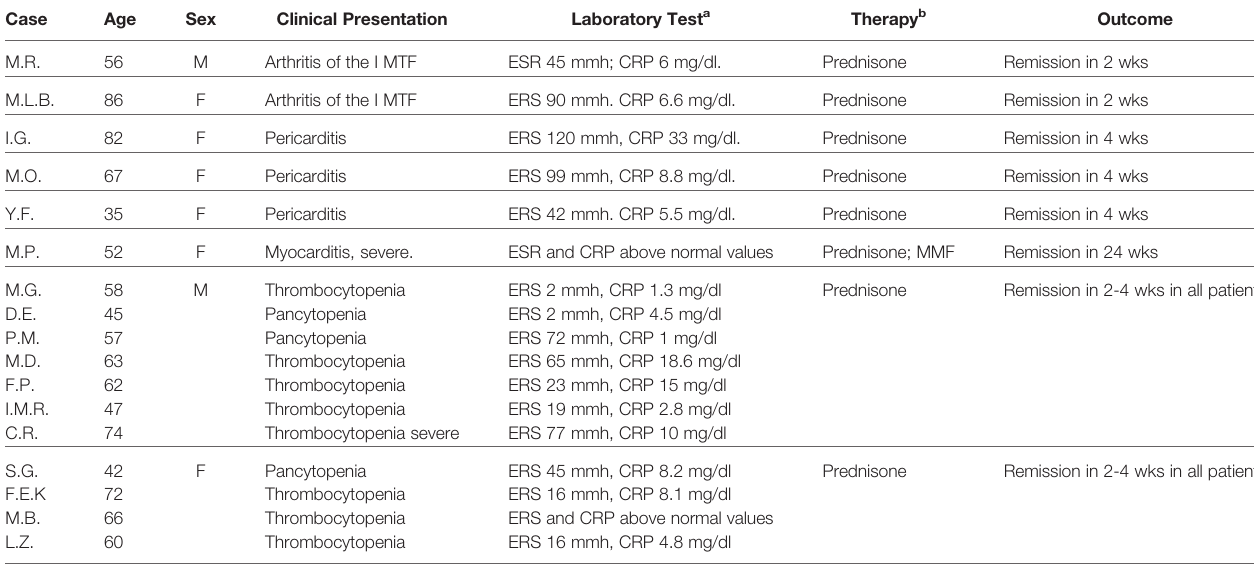
Age: years. Sex: M, male, F, female. a Laboratory Test: in all the patients the serum levels of anti-nuclear antibodies (ANAs), anti-cytoplasmic ANCA (c-ANCA) and anti-perinuclear ANCA (p-ANCA) antibodies, rheumatoid factor and anti-citrullinated protein antibodies (ACPAs), and anti-Ro, anti-La, anti-dsDNA, anti-Sm autoantibodies were tested and resulted in the normal range. b Prednisonewasadministeredatthedoseof25mg/day,scalingthedoseuntilthestopin2-4weeks,inallthepatients.Incasen.6prednisonewasadministeredatthedoseof25mg/day foroneweek, scalingthedose in8 weeks totheminimum doseof 4mg/day and, because thepatient wasstill symptomatic, mycophenolate mofetilwas addedatthe doseof 1gr twice a day. Wks, weeks; ESR, erythrocyte sedimentation rate; CRP, C-reactive protein; MMF, Mycophenolate